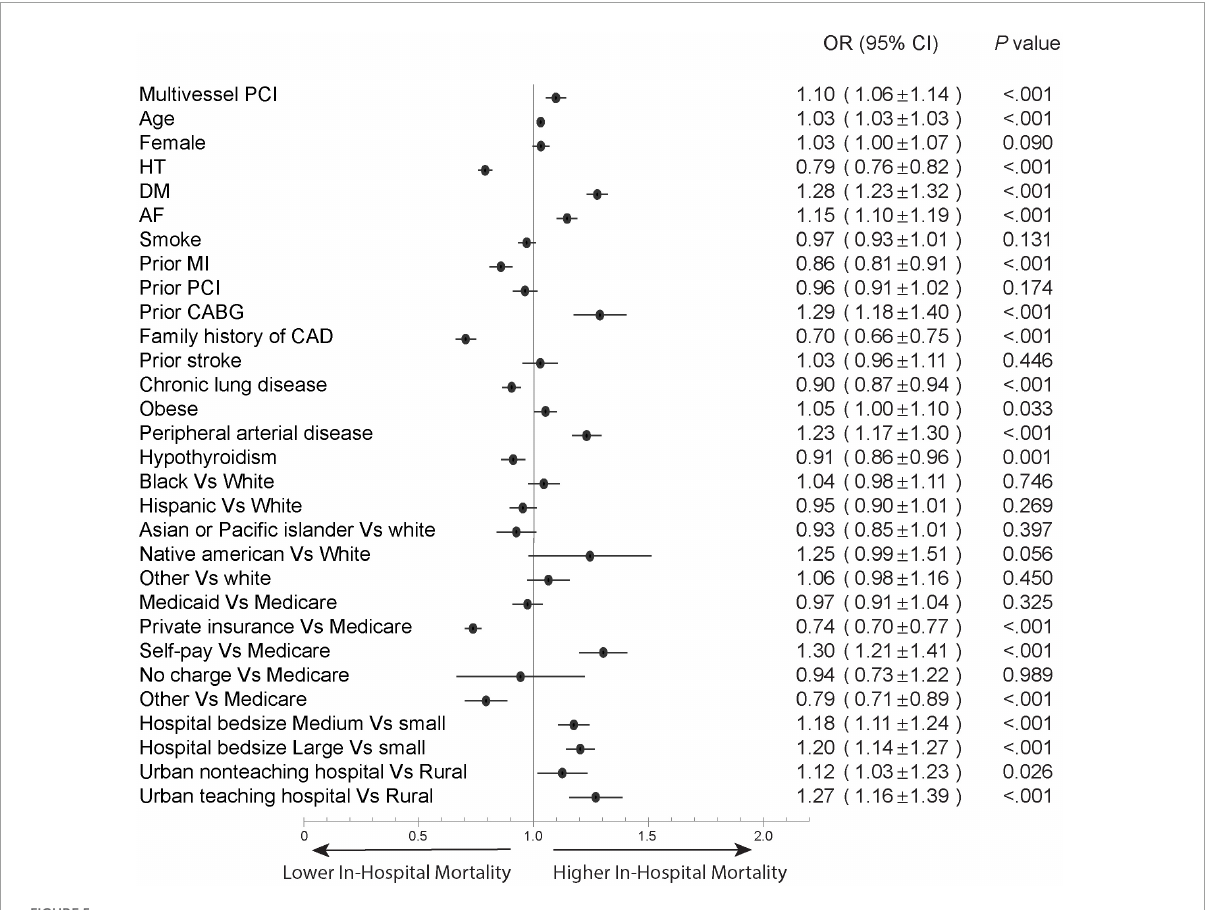
FIGURE5 Forest plot of multivariable regression analysis to predict in-hospital mortality in the STEMI with cardiogenic shock cohort. Abbreviations as in Figure 3